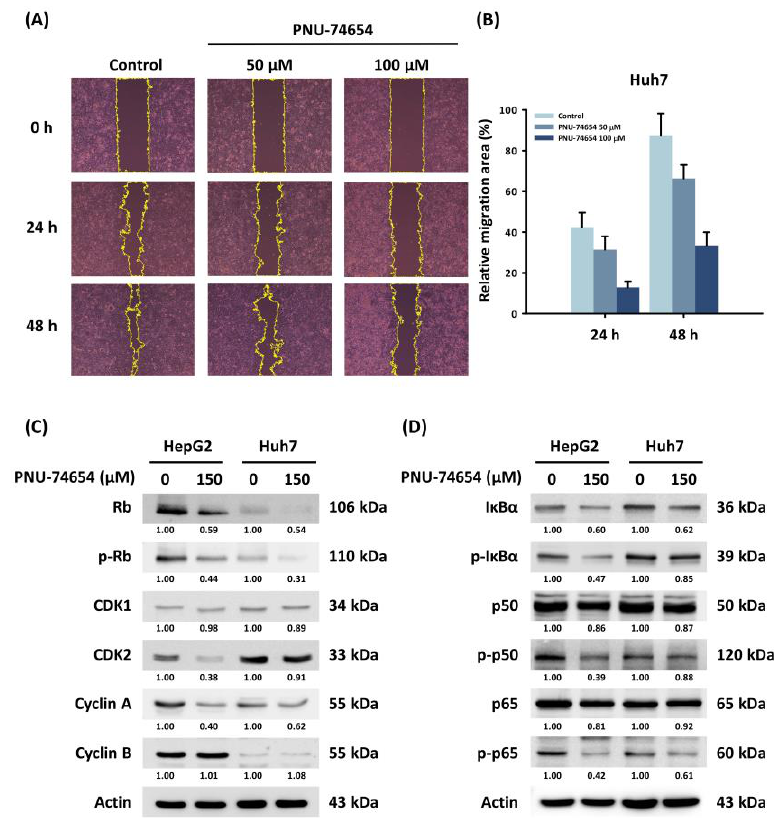
Figure 3. Effects of PNU-74654 on the migration of HCC cells and on the regulation of the cell cycle and the NF- κ B pathway. ( A ) The migration ability of Huh7 cell, detected with a wound healing assay. ( B ) Quantification of relative migration area of Huh7 cell on 24 and 48 h. Bars depict means ± SD. ( C , D ) Western blots showing changes in protein expression by